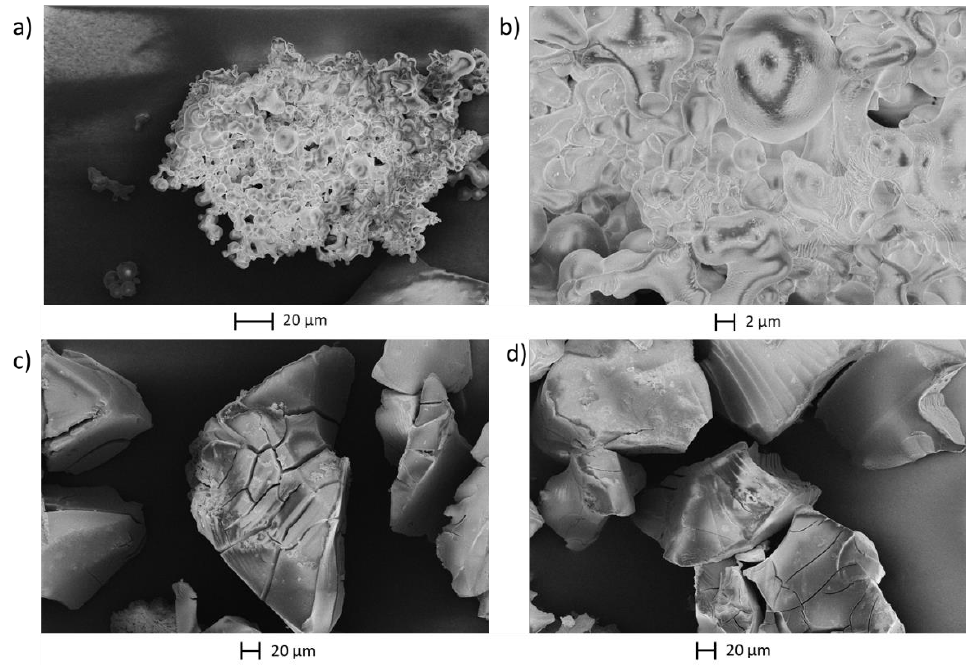
Figure 10. SEM micrographs after the oxidative catalysis with HPA-5 ( a ) F1 ( b ) F1 zoomed in ( c ) F4 ( d ) F7.